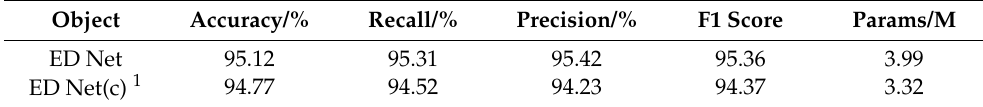
Table 4. Comparison results of DPCI_SE Block and CAM experiments.